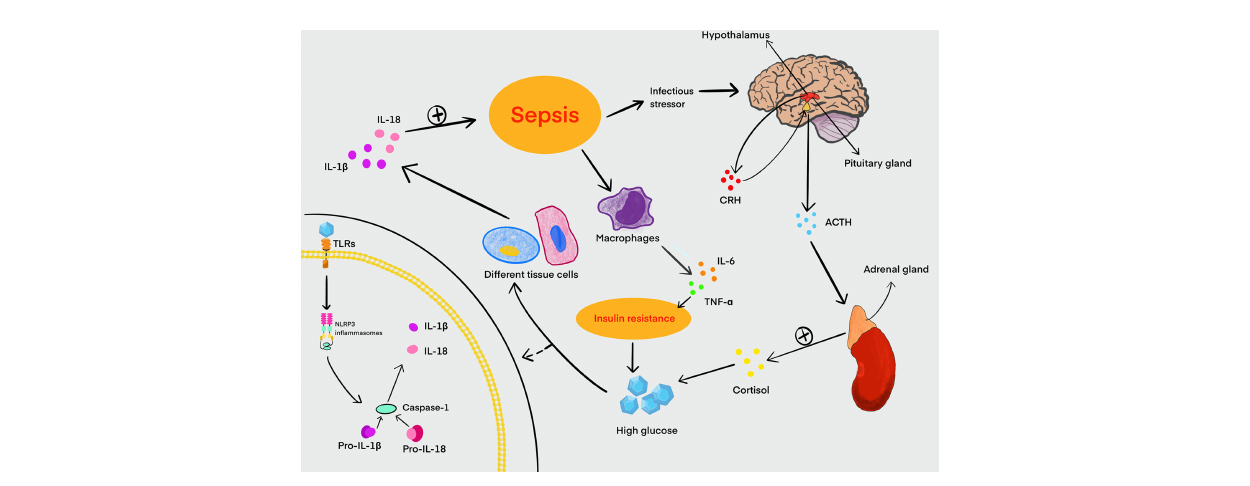
FIGURE 2 | Relationship between HG and sepsis. Sepsis can stimulate the hypothalamus to increase the secretion and release of CRH. Meanwhile, CRH promotes the synthesis and release of ACTH from the pituitary gland, and ACTH in turn stimulates the adrenal cortex to secrete cortisol, which can lead to an increase in blood glucose. Sepsis can also stimulate macrophages to secrete large amounts of IL-6, TNF- a , and other proin fl ammatory mediators. These proin fl ammatory mediators can disrupt the signaling of the insulin transduction pathway, and it is a major cause of insulin resistance in the host. Insulin resistance can further exacerbate HG in turning. Glucose is recognized by TLRs in a variety of tissue cells and activates NLRP3 in fl ammasomes that can cleave pro-caspase-1 into activated caspase-1 to induce in fl ammation. Activated caspase-1 processes pro-IL-1 b and pro-IL-18 to form mature IL-1 b and IL-18, promoting the development of in fl ammation in sepsis. HG, high glucose; CRH, corticotropin-releasing hormone; ACTH, adrenocorticotropic hormone; IL, interleukin; TNF, tumor necrosis factor; TLRs, Toll-like